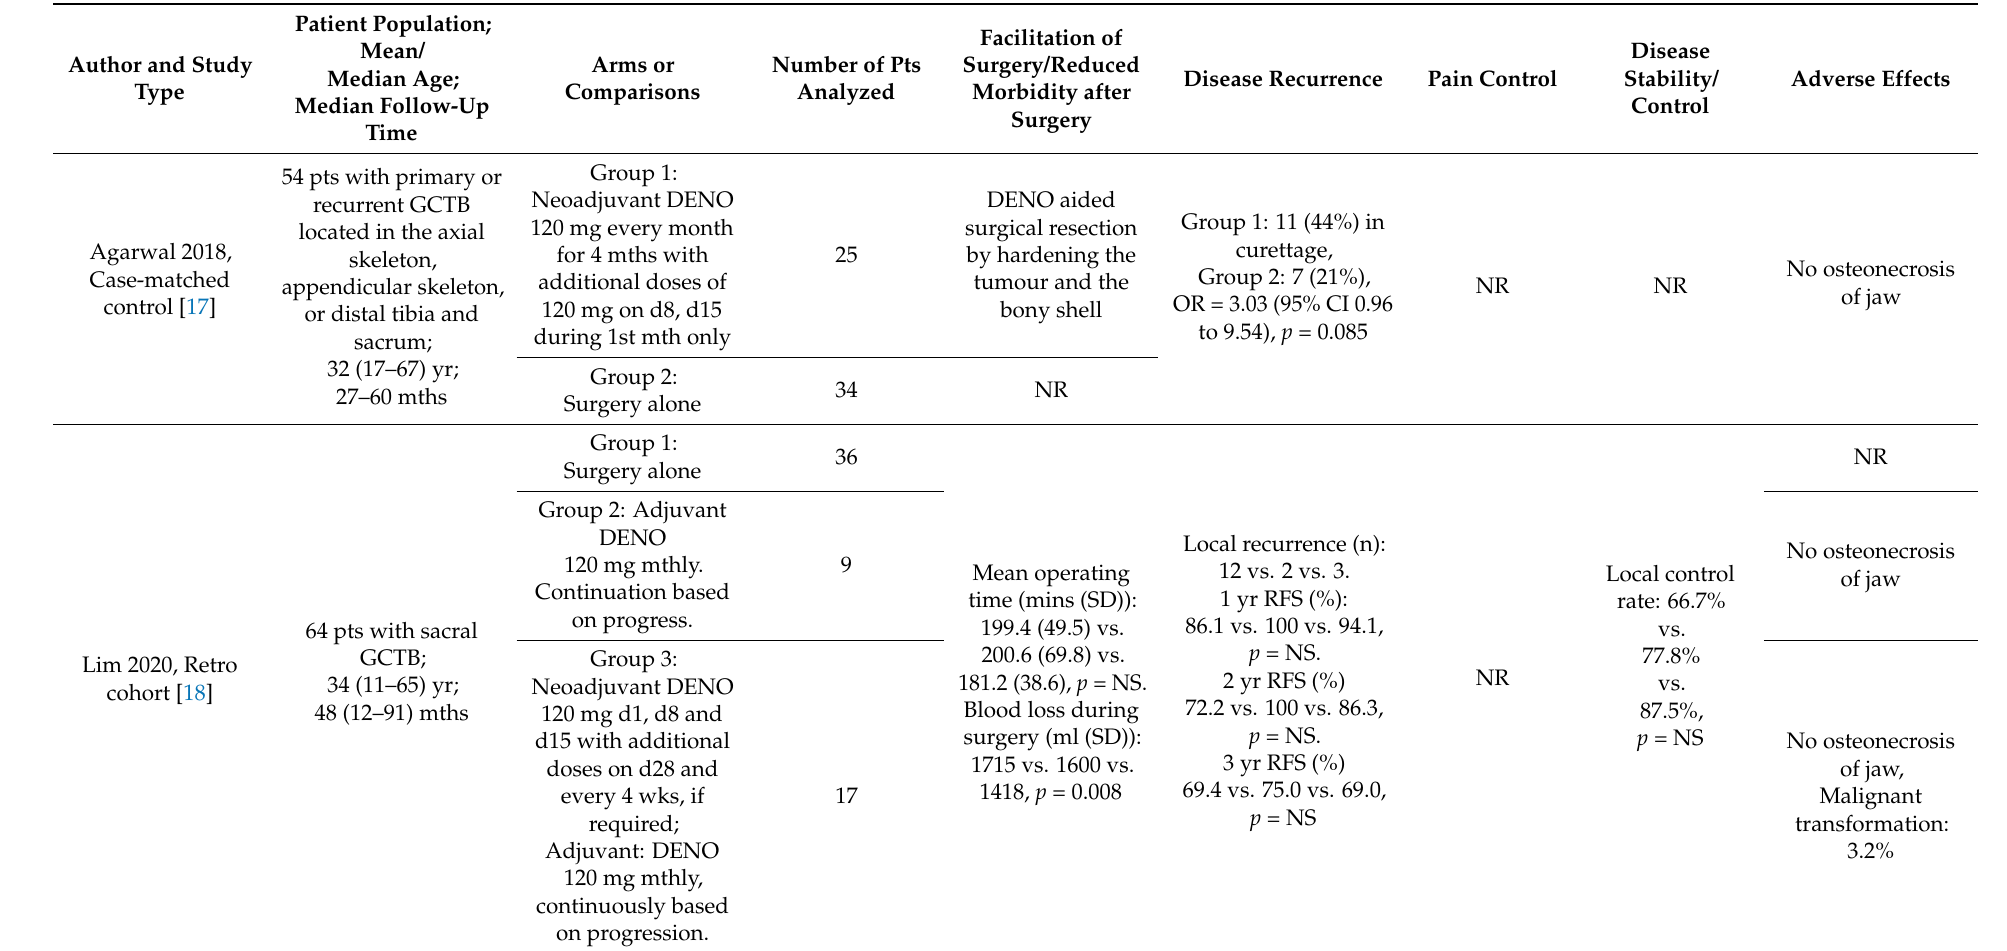
Table 3. Studies comparing DENO administration vs. no DENO